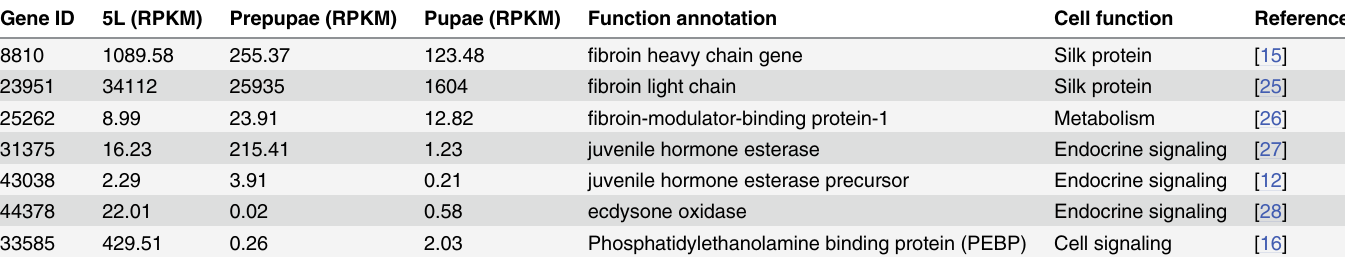
Table 4. Expression abundance of genes related to silk formation identified in the indicated citations. 5L = 5th instar